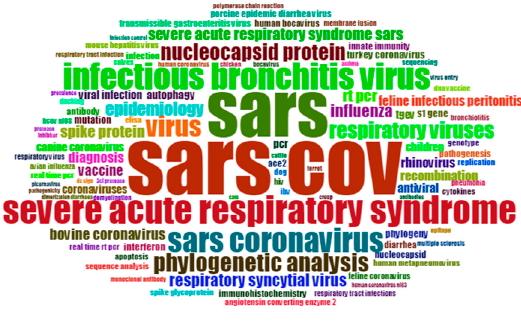
Figure 5. Keywords cloud map of 2008–2011. Table 5. Items and frequency of hot keywords during 2008 – 2011.